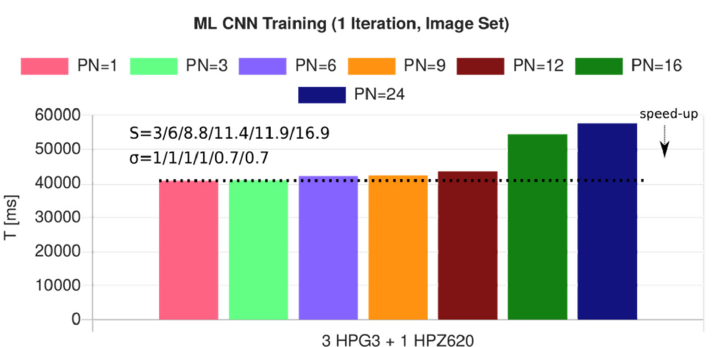
Figure 16. Results of the total computation times, with a distributed-parallel cluster, with shell workers processing multi-model CNN-ML training using a different number of distributed and parallel workers PN. HPG3: NC = 4, HPZ620: NC = 12. parallel workers PN. HPG3: NC = 4, HPZ620: NC = 12.